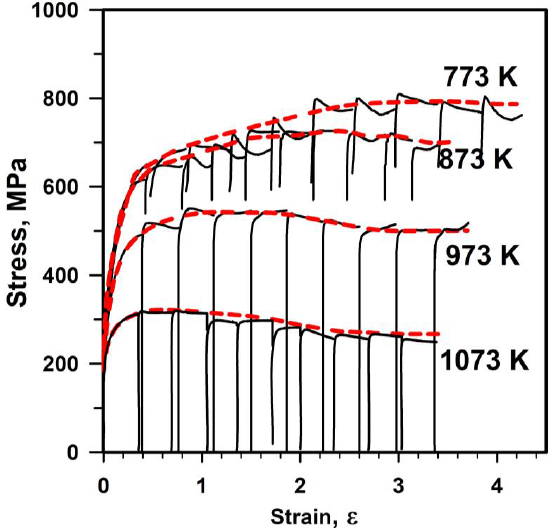
Figure 8. True stress – strain curves during multiple forgings of a 304-type stainless steel at indicated temperatures. Adapted from [65,69] with permission from Elsevier, 2023. Typical deformation microstructures evolved in a 304-type stainless steel during multiple multidirectional forging at 773 K are shown in Figure 9 [70]. A number of strain- induced grain boundaries are clearly seen in the sample subjected to three sequential forg- ing passes to a total strain of 1.2. The new ultrafine grains frequently develop along orig- inal grain boundaries and their triple junctions, where large strain gradients and corre- sponding high density of strain-induced boundaries evolve. The number of new fine grains and the volume fraction of ultrafine grains increase during SDP, leading to UFG microstructure after sufficiently large total strain ( ε = 4 after ten forging passes in Figure 9). An increase in SPD temperature does not lead to qualitative changes in the microstruc- ture evolution, although individual uncompleted strain-induced boundaries are observed near original grain boundaries and their junctions after one forging pass at 973 K (arrows for ε = 0.4 in Figure 10) [70]. Further processing results in the mixed microstructure con- sisting of irregular remnants of original grains and strain-induced ultrafine grains. An increase in processing temperature under conditions of warm working apparently accel- erates the development of UFG microstructure in the austenitic stainless steel. The UFG fraction in the sample subjected to multiple forging at 973 K to a total strain of 2 comprises about 0.9, whereas that of about 0.6 is observed at 773 K after the same strain. Therefore, an increase in deformation temperature promotes the development of continuous DRX during warm deformation similar to that discussed above for ferritic stainless steels.